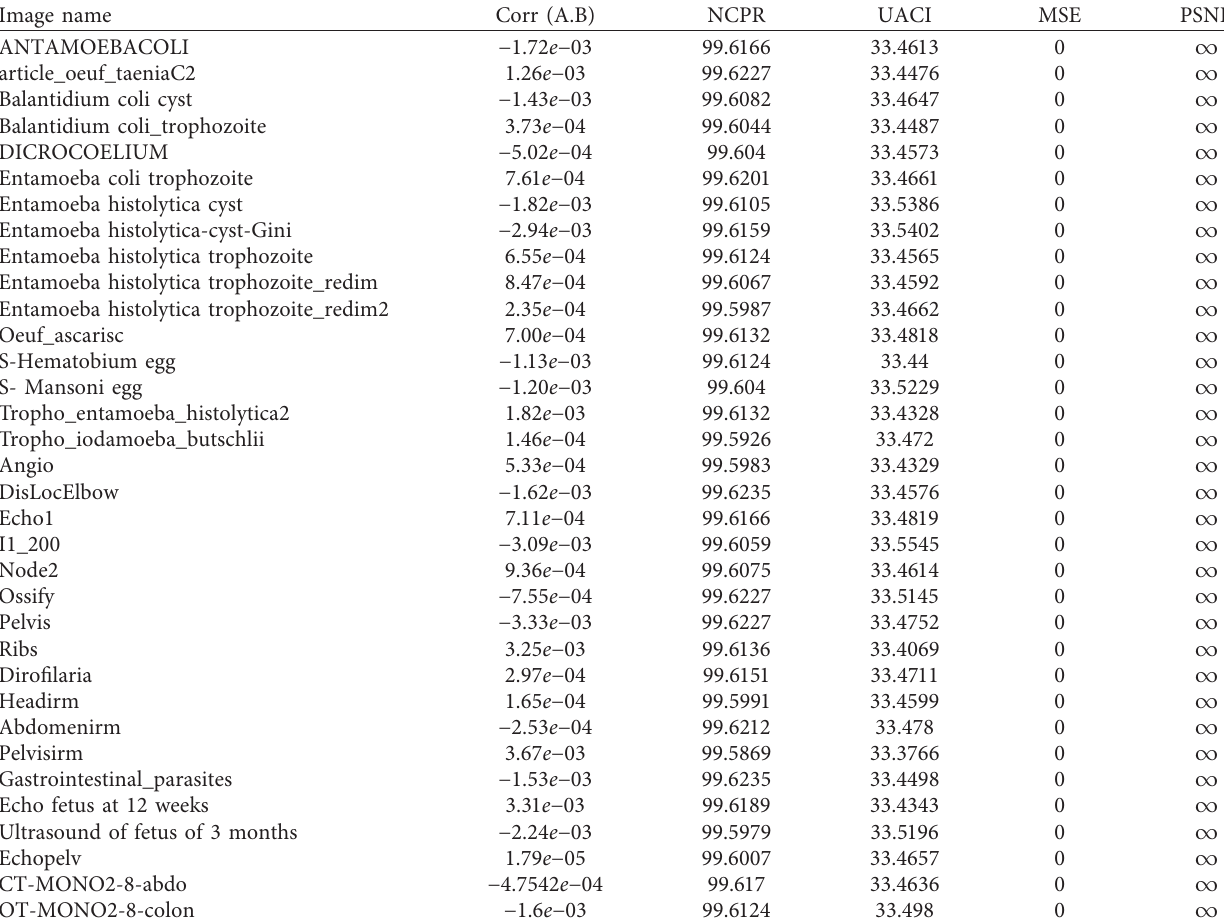
Table 10: Values of the number of pixels change rate (NPCR) and unified average changing intensity (UACI) in several medical images. Image